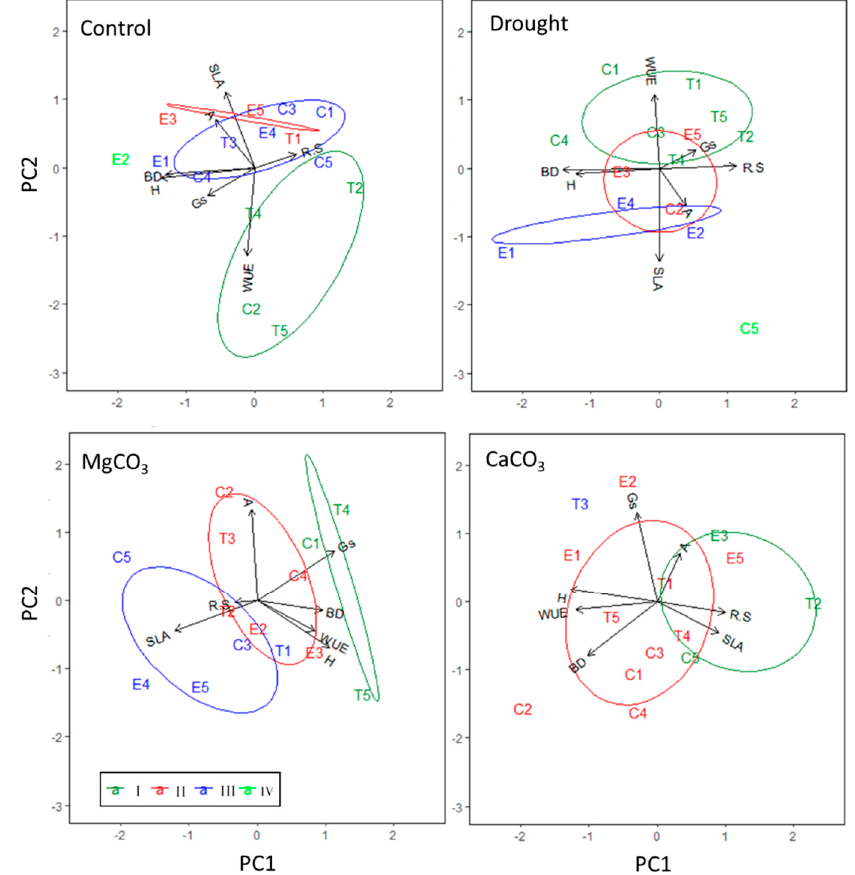
Figure 1. Principal component analysis (PCA) of seven plant traits (seedling height, basal diameter, root:shoot ratio, specific leaf area, photosynthesis rate, stomatal conductance, instantaneous water use efficiency) in the seedlings of five half-sib families within populations for each applied treatment. Principal components 1 and 2 in the control treatment explained 32% and 24% of variance, respectively, in treatment drought with 34% and 22%, respectively, with Mg inputs 37% and 21%, respectively, and with Ca inputs 40% and 21%, respectively. Half-sib families (T1 to T5, C1 to C5, E1 to E5) refer to the half-sib families within the Toledo, Calderona, and Espadà populations, respectively. Different coloured ellipses delimited the half-sib families’ clustering based on the Euclidean distances estimated by hierarchical dendrograms (Figure S1 in the Supplementary Materials).